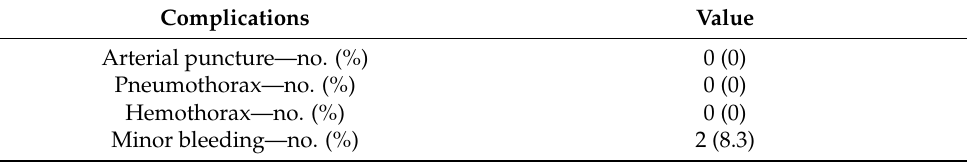
Table 4. Post-procedural complications after HDC placement, monitored at least 24 h. Complications Value Arterial puncture — no. (%)